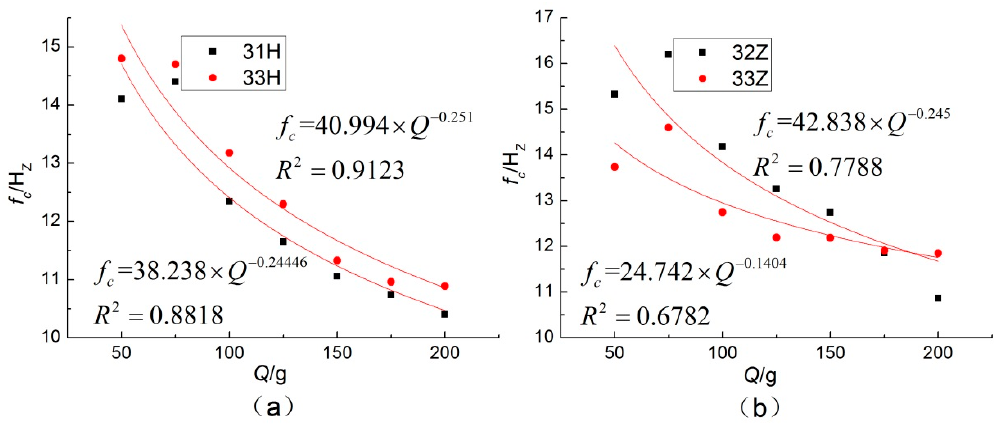
Figure 13. The attenuation curve of the average frequency ( R = 2.7 m).